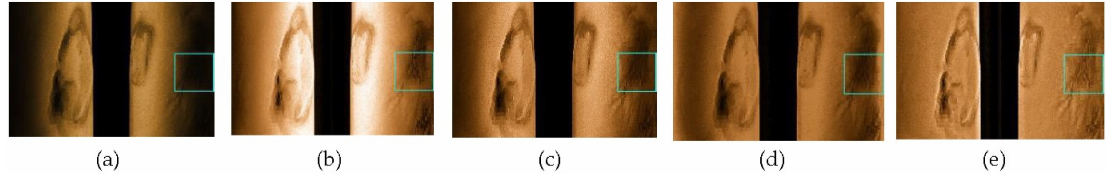
Figure 15. Comparison experiments of common methods used to correct side-scan sonar images: ( a ) The original side-scan sonar image, ( b ) histogram, ( c ) non-linear compensation, ( d ) function fitting, and ( e ) our